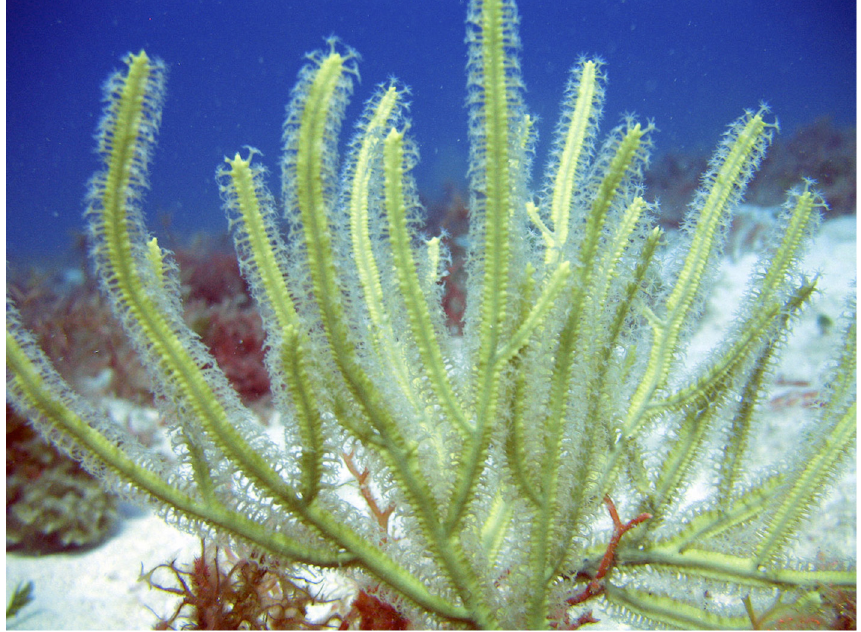
Fig 3. A unique morphotype of Pterogorgia from Saba Bank. This morphotype is similar to P . citrina by containing distinct calyces, but approaches P . guadalupensis in branch shape with flat branches over 7mm in width. Photo by J.A.